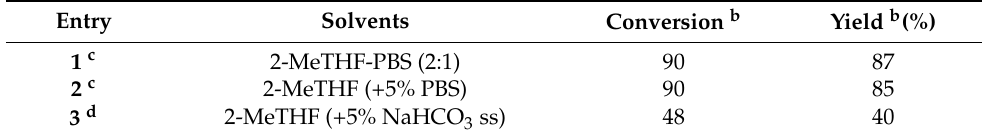
Table 2. Optimization experiments for the synthesis of hydro-peroxide 2b a